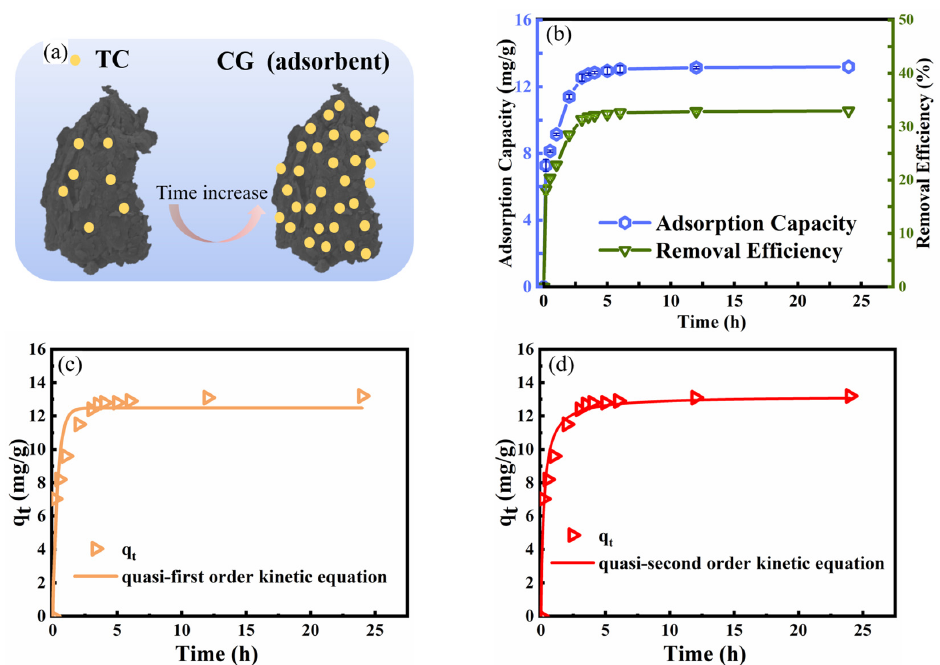
Figure 2. The adsorption kinetic curves of TC by CG: ( a ) the proposed schematic diagram of TC adsorption by CG with increasing contact time; ( b ) effect of contact time on TC adsorption by CG, ( c ) the quasi-first order kinetic model fitting line; ( d ) the quasi-second order kinetic model fitting line. (TC concentration of 40 mg/L, CG dosage of 1 g/L, pH of 6.2, contact temperature of 25 °C, and stirring speed of 120 rpm).